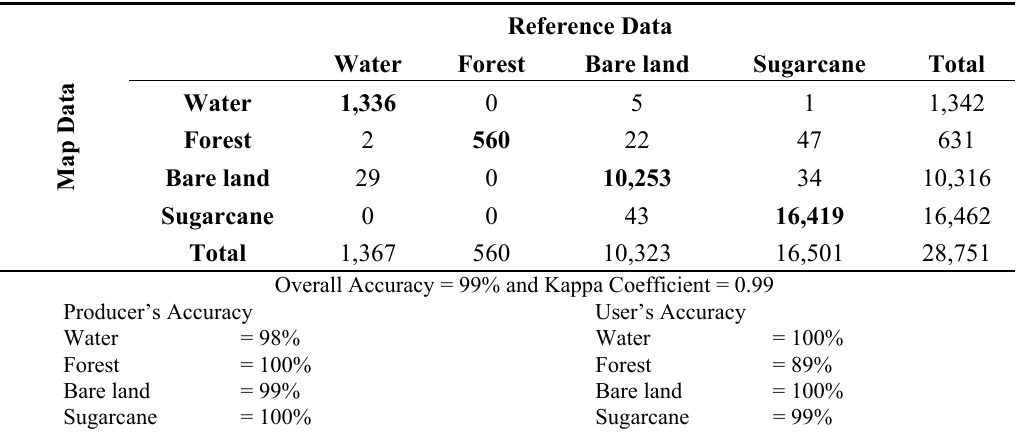
Table 11. Error matrix of LULC classification accuracy assessment for THEOS images of Suphanburi Province (sugarcane